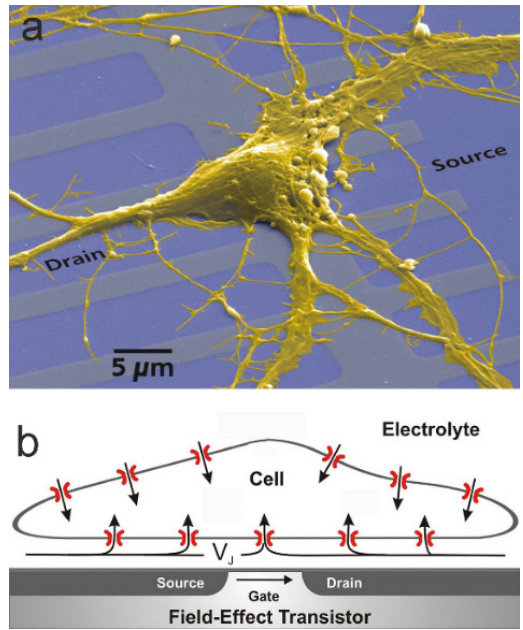
Figure 1. Planar cell-substrate junction with an EOSFET (electrolyte-oxide-semiconductor field-effect transistor), implementing the coupling of ionic and electronic currents: ( a ) Electronmicrograph of a cultured nerve cell from rat hippocampus on the silica surface of a silicon chip with an array of EOSFETs (by permission [3]). ( b ) Schematic cross section (not to scale). A cleft of about 50 nm with extracellular electrolyte separates the cell membrane and the silica surface. Ionic and capacitive currents through the cell membrane give rise to a current flow along the cleft. The ionic current induces a voltage V J with respect to the bath and modulates the electronic source-drain current at a constant gate voltage applied to a reference electrode in the bath.